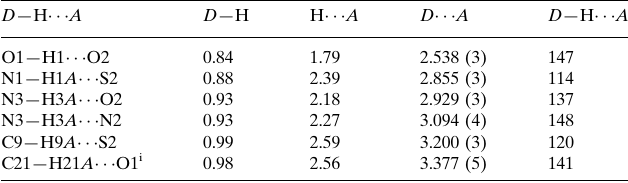
Hydrogen-bond geometry (A˚ , (cid:3)